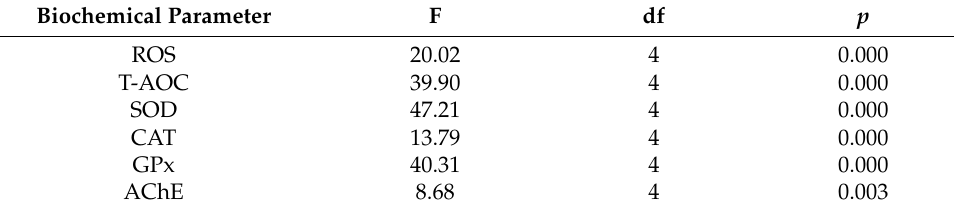
Table 4. Effects of K. mikimotoi concentrations on biochemical parameters in T. japonicus .